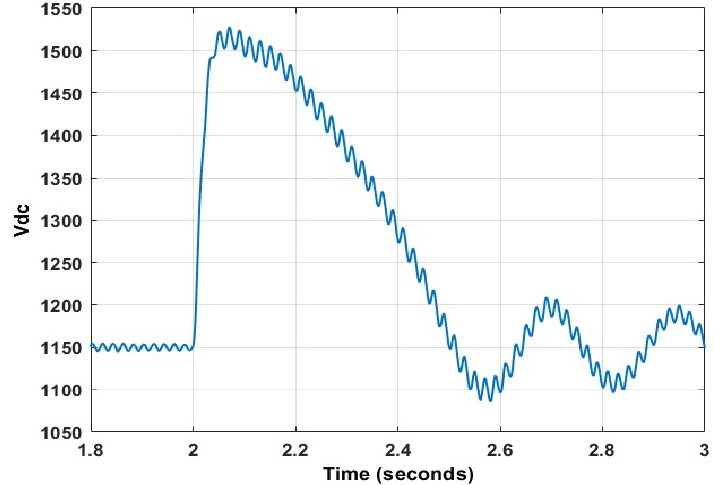
Figure 41. Rotor current transient using LQR at 80% dip.